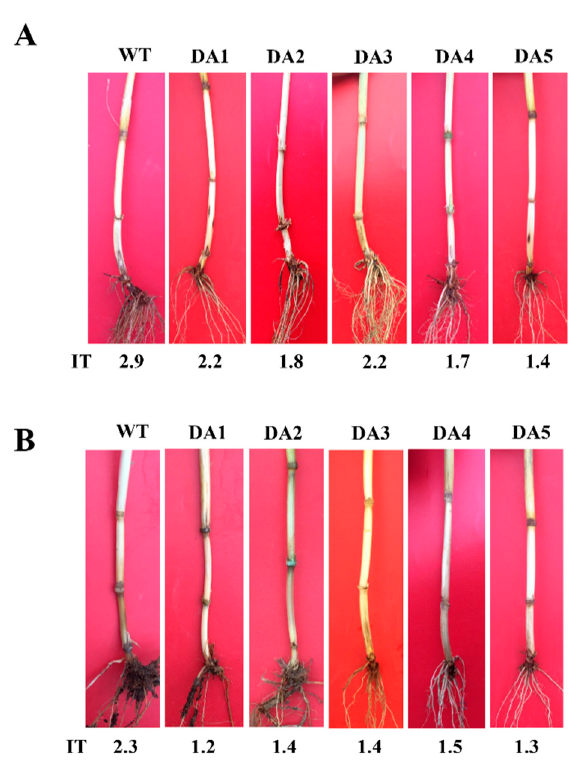
Figure 4. Typical symptoms of sharp eyespot and common root rot in DmAMP1W transgenic and non-transformed wheat plants. ( A ) Typical symptoms of sharp eyespot in DmAMP1W transgenic wheat lines and non-transformed wheat cv. Zhoumai18. Zhoumai18 was the transgenic recipient. DA1, DA2, DA3, DA4 and DA5 represent DmAMP1W transgenic wheat lines. IT indicates infection type. WT represents the recipient Zhoumai18. ( B ) Typical symptoms of common root rot in DmAMP1W transgenic wheat lines and non-transformed wheat cv. Zhoumai18. DA1, DA2, DA3, DA4 and DA5 indicate DmAMP1W transgenic wheat lines. IT represents infection type. WT represents the recipient Zhoumai18. Table 1. Responses of DmAMP1W transgenic wheat lines to sharp eyespot.